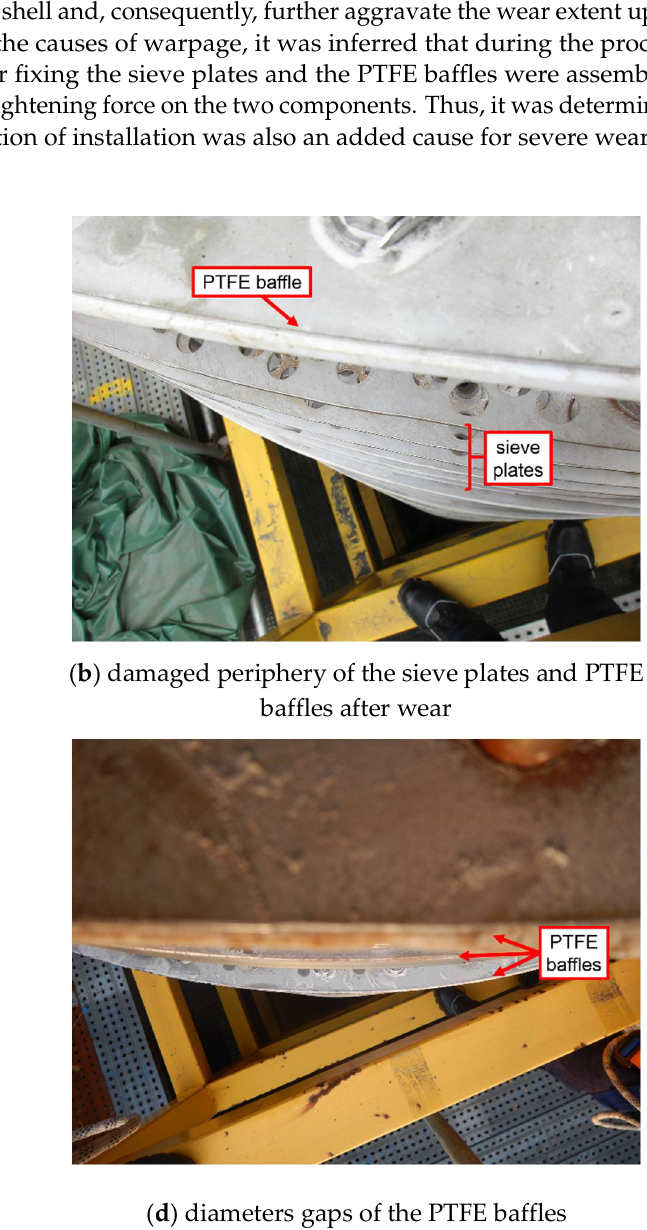
Figure 12. External appearances of the tray.